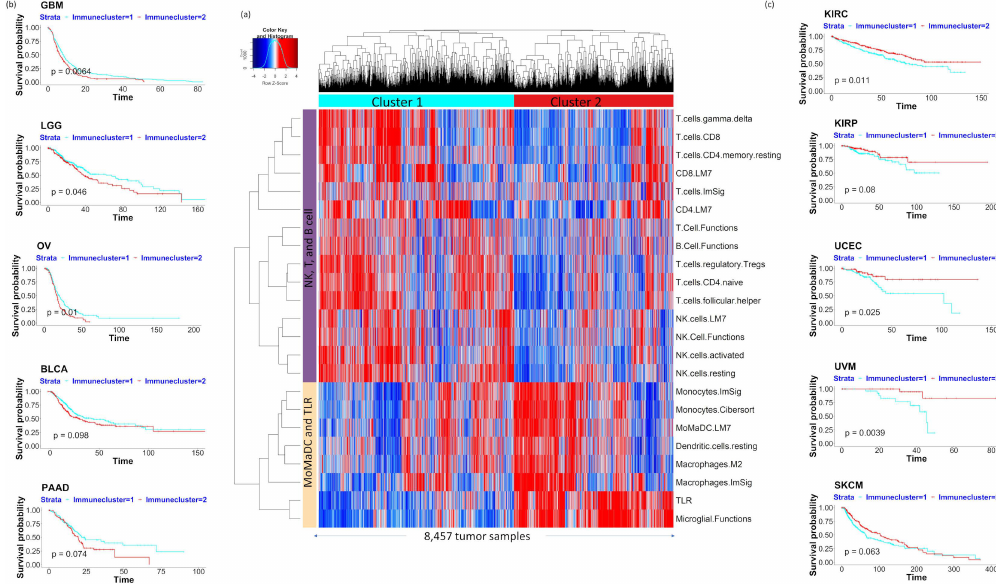
Figure 2. ssGSEA of bulk tumor RNA-Seq data from 20 TCGA tumor types. ( a ) Unsupervised clustering of ssGSEA scores of immune signatures across 20 cancer types identifies two distinct clusters: one enriched for NK-, T-, and B-cell functions, and the other enriched for macrophage, monocyte, dendritic cell, and TLR functions. ( b ) Cluster 1, which is enriched for NK-, T-, and B-cell functions, was associated with better survival (disease-free survival [DFS] or overall survival [OS]) for GBM, LGG, PAAD, BLCA, OV, and BRCA. ( c ) Cluster 2, which is enriched for TLR, microglial, macrophage, monocyte, and dendritic cell functions, was associated with better survival (DFS or OS) for UCEC, UVM, KIRC, KIRP, and